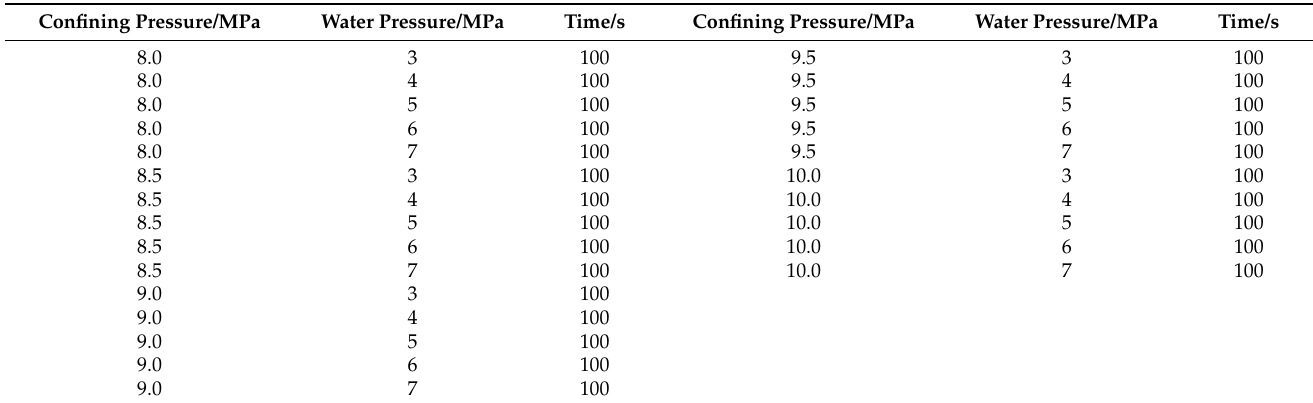
Table 1. Test scheme for the seepage characteristic of sandstone samples.